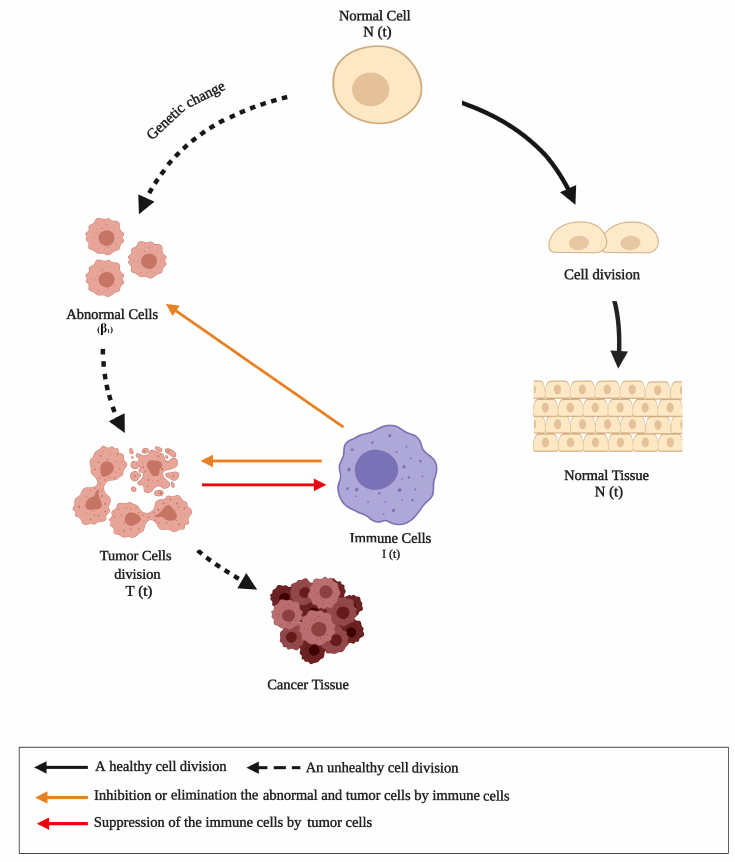
Figure 1. A biological scenario of progressive cancer as a result of abnormal cell